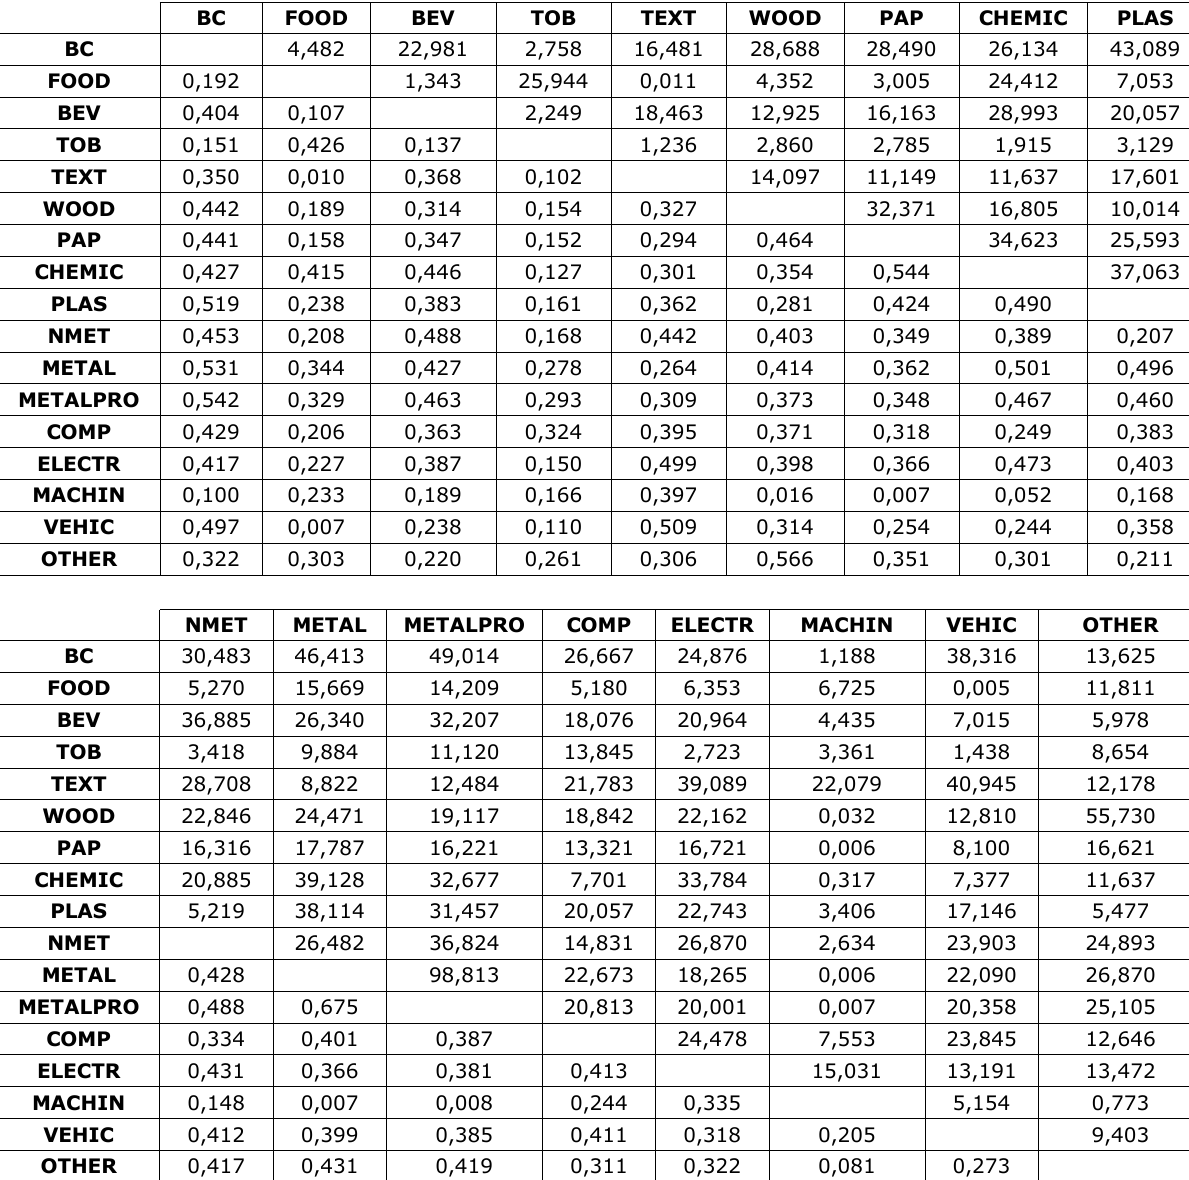
Table B.2.  2 in the upper triangle and contingency index (CP) in the lower triangle